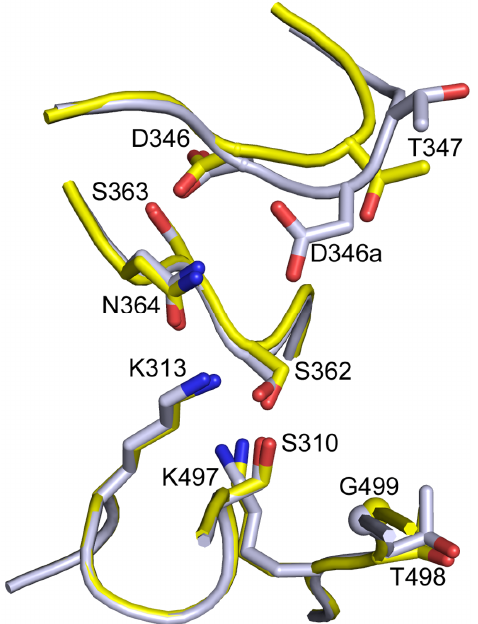
Figure 3. Superimposition of the structures of the active site of N. gonorrhoeae PBP2 with sequence XII (grey) and sequence P08149 (yellow), which are from resistant and susceptible strains, respectively. The additional D346a side chain protrudes inside the active site, towards the reactive serine 310.